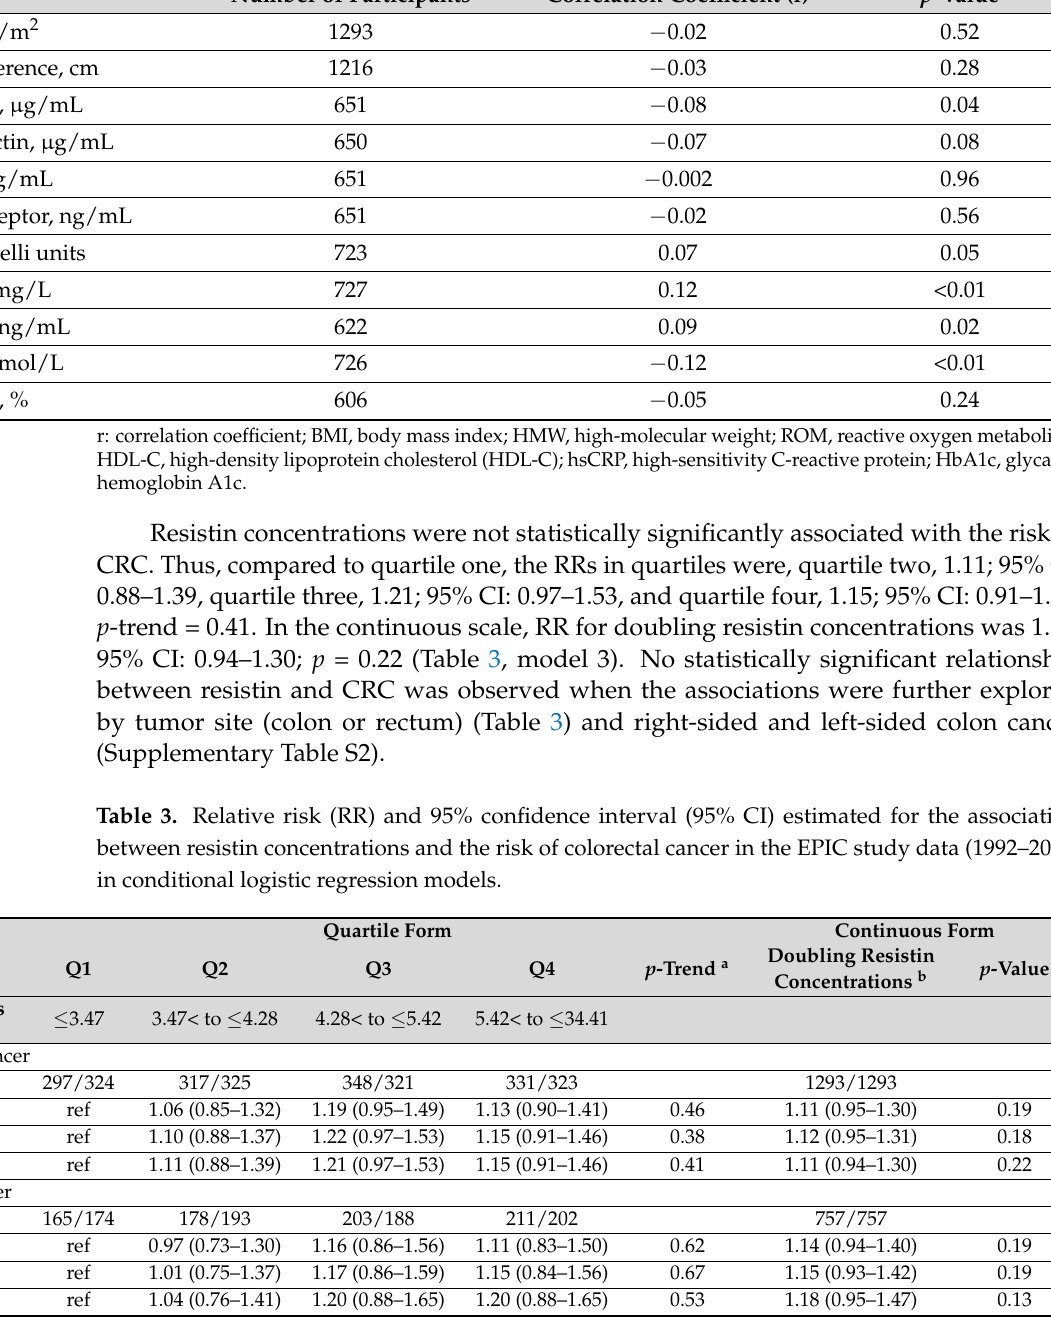
Table 2. Age- and sex-adjusted Spearman partial rank correlations between resistin and adiposity measurements, other adipokines, as well as metabolic and inflammatory biomarkers in controls (n = 1293), the European Prospective Investigation into Cancer and Nutrition Cohort (1992–2005). Number of Participants Correlation Coefficient (r) p -Value 1293